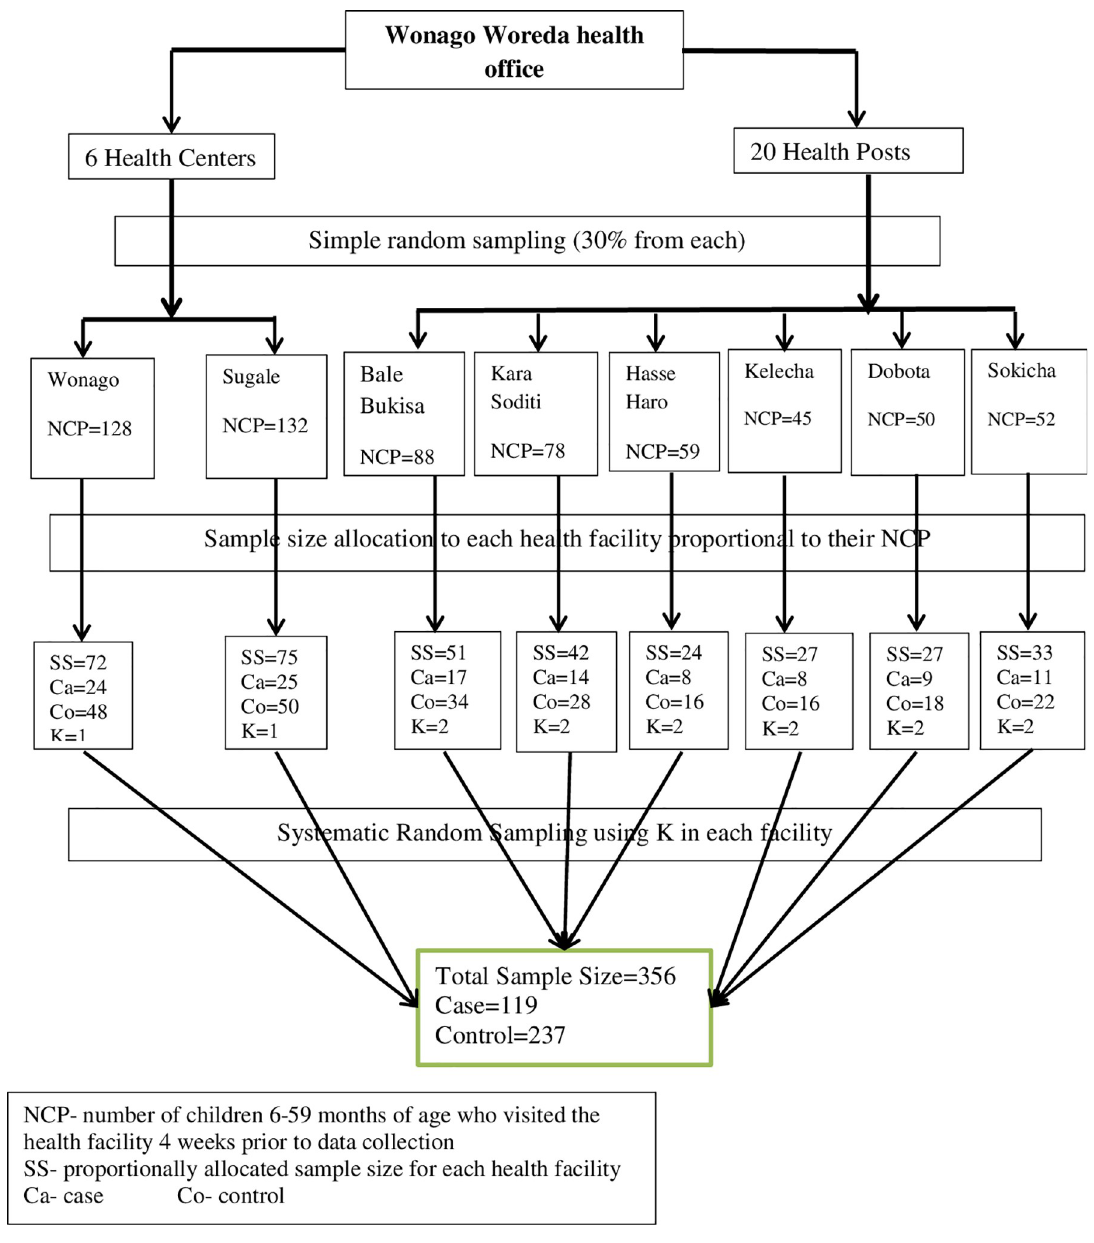
Fig 1. Schematic presentation of sampling procedure for the study on determinants of acute malnutrition among children aged 6–59 months in study area,